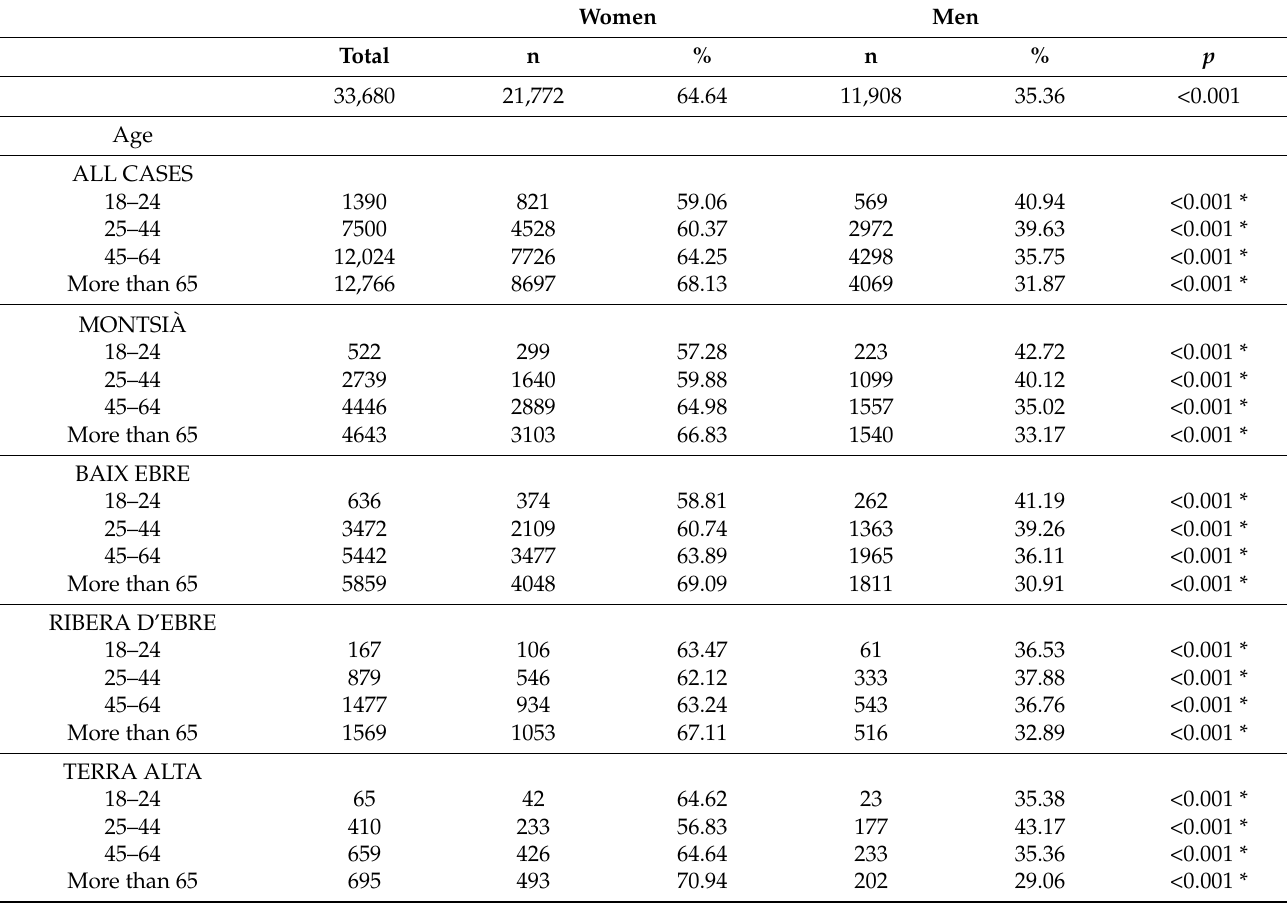
Table 1. Sociodemographic characteristics of the